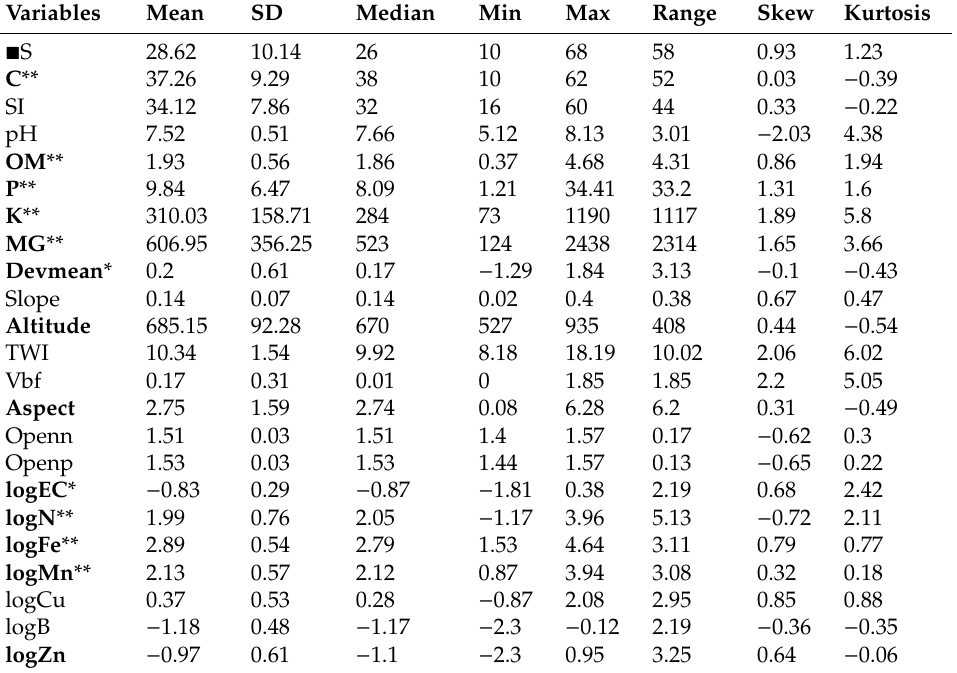
Table 6. Descriptive statistics of auxiliary variables from the 266 locations in the Grevena area, Greece.